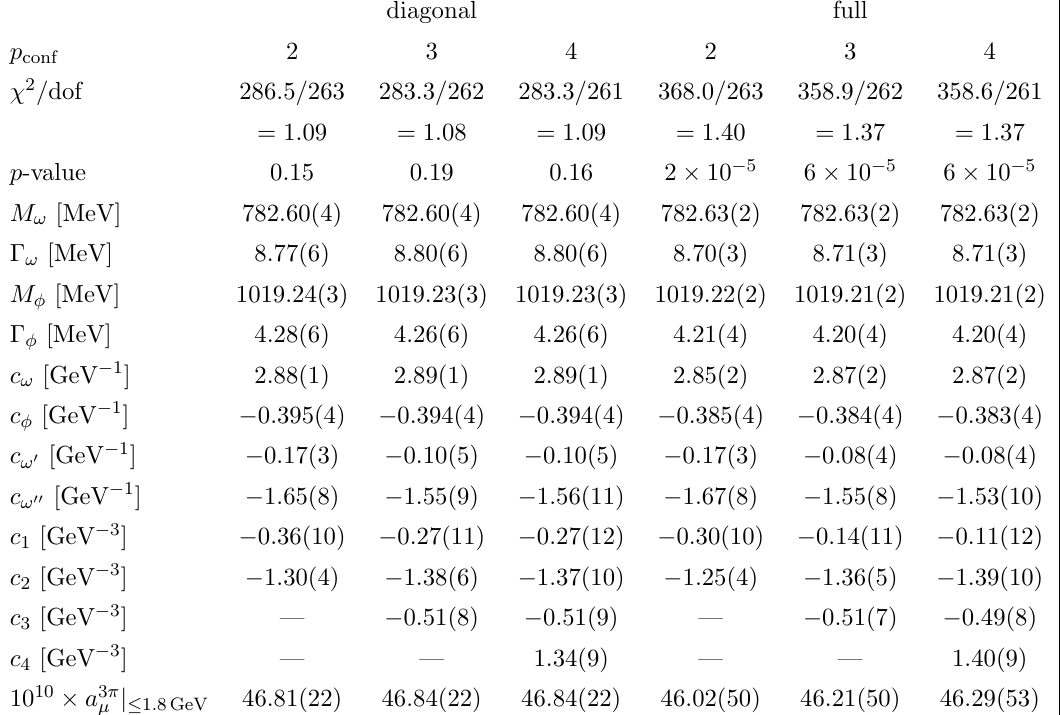
Table 7 . Fits to the combination of SND [69{72], CMD-2 [63, 73, 74], BaBar [68], DM1 [76], and ND